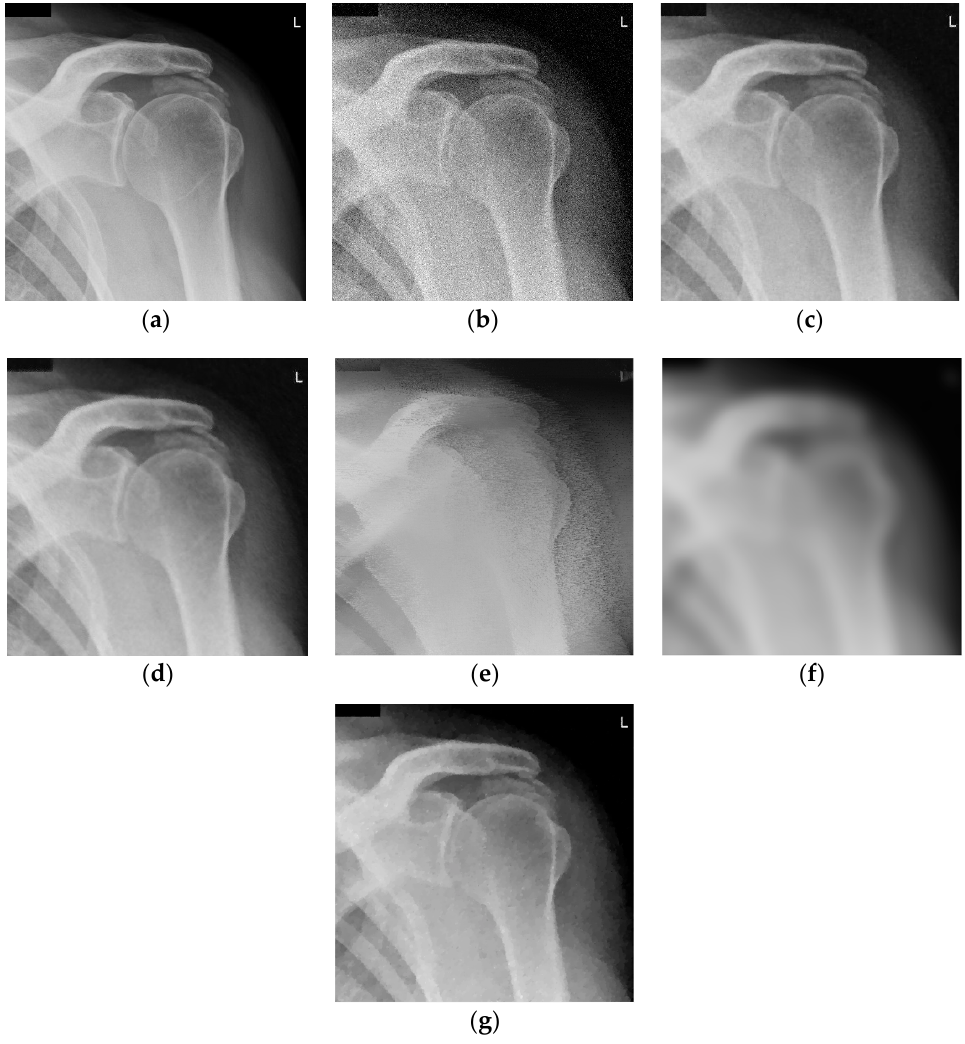
Figure 3. Shoulder X-ray scan. ( a ) Original noise-free image; ( b ) Noisy image (AWGN with σ = 25); ( c ) Image denoised using the 2D LPA-RICI method (quadrilateral region, Г = 1.8, Rc = 0.8); ( d ) Image denoised using the 2D LPA-RICI method (octagonal region, Г = 1.8, Rc = 0.8); ( e ) Image denoised using the 2D LPA-RICI method (hexadecagonal region, Г = 1.8, Rc = 0.8); ( f ) Image denoised using Gaussian smoothing filters; ( g ) Image denoised using total variation denoising.